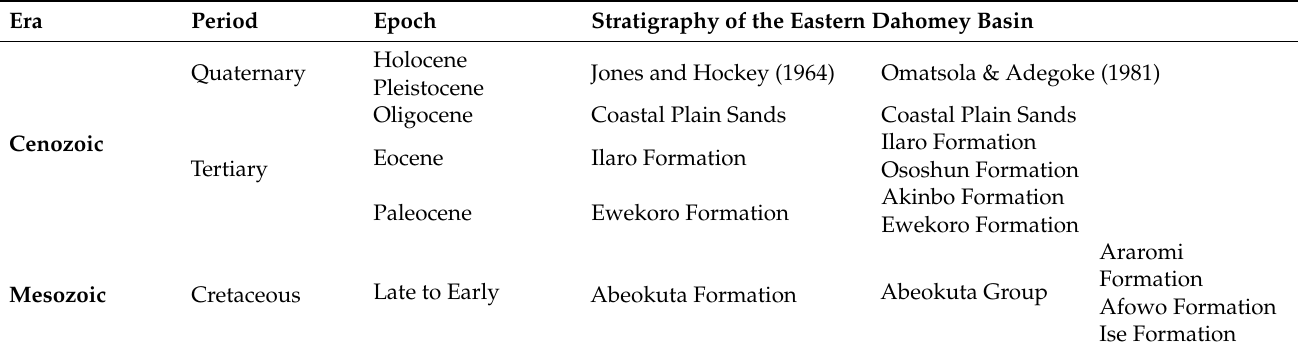
Table 1. Stratigraphy of the Eastern Dahomey Basin